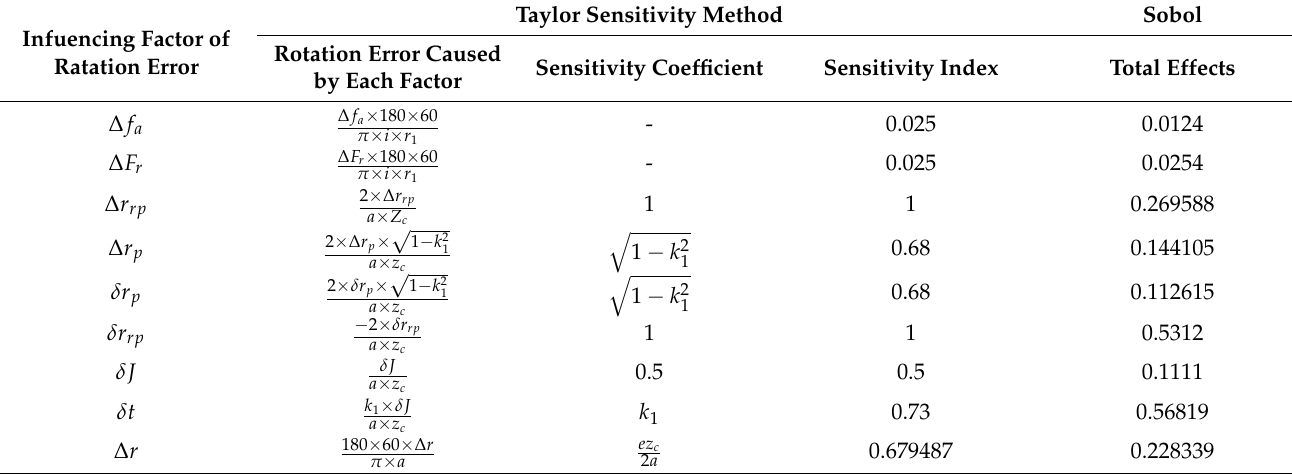
Table 9. Comparison of the sensitivity indexes of the factors influencing the rotation error obtained by the two methods. Taylor Sensitivity Method Infuencing Factor of Ratation Error